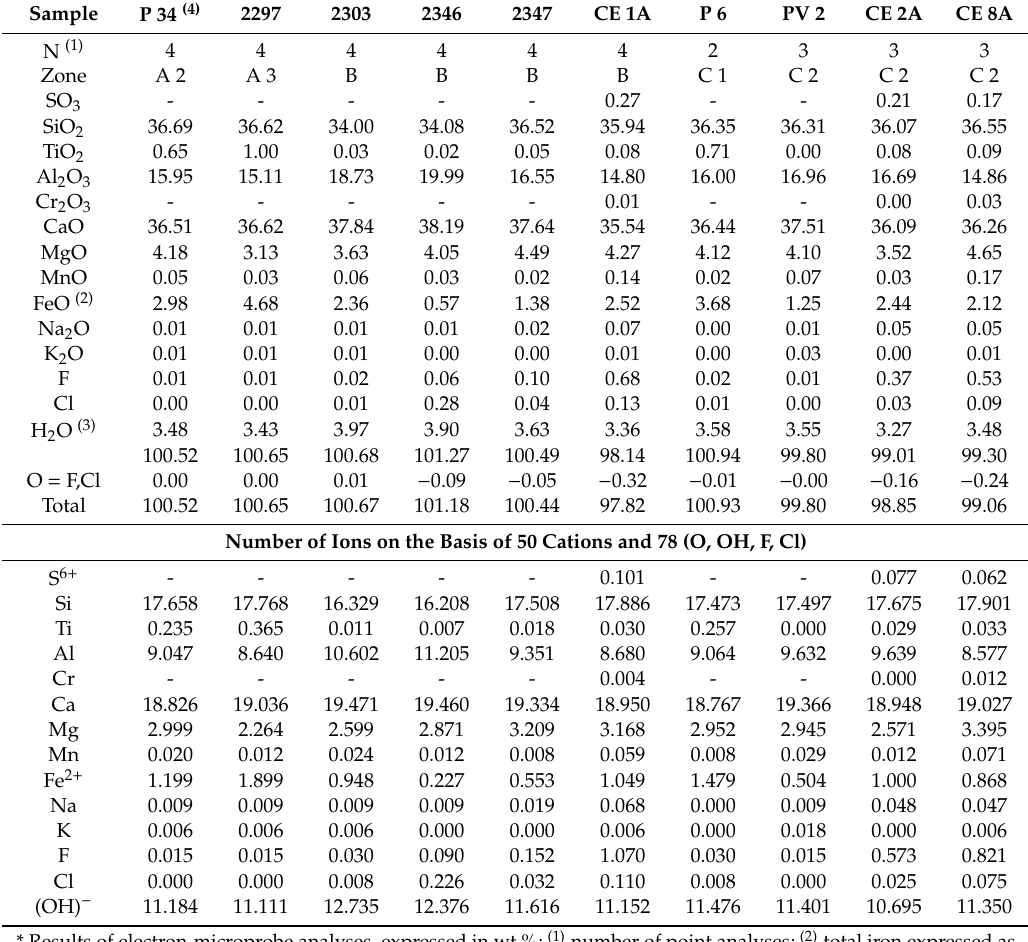
Table 11. Representative compositions of vesuvianite, M ă gureaua Va¸tei